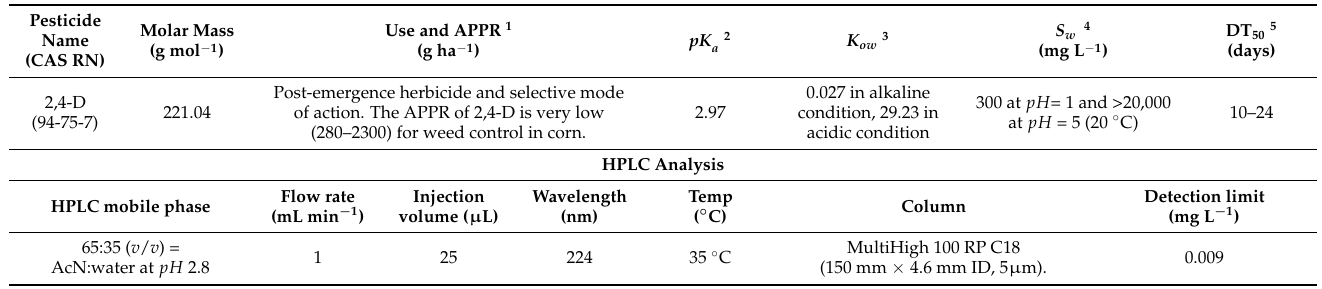
Table 2. Uses, properties, and analytical details for